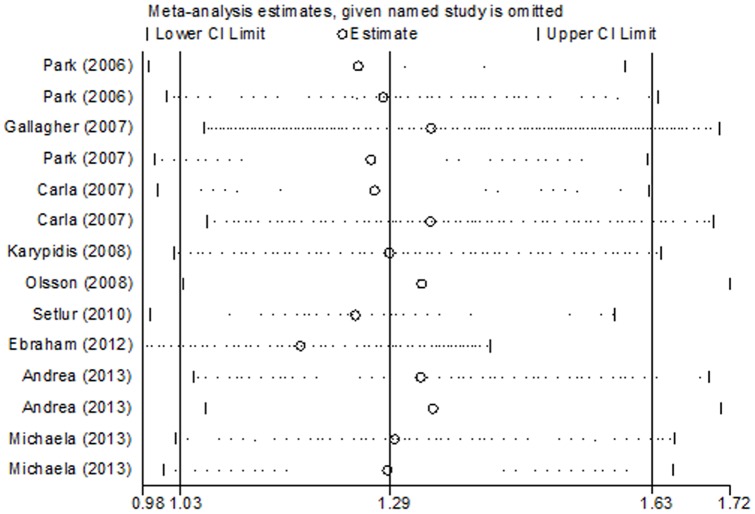
Influence analysis for the recessive model in the overall meta-analysis.The figure shows the influence of individual studies on the summary OR.